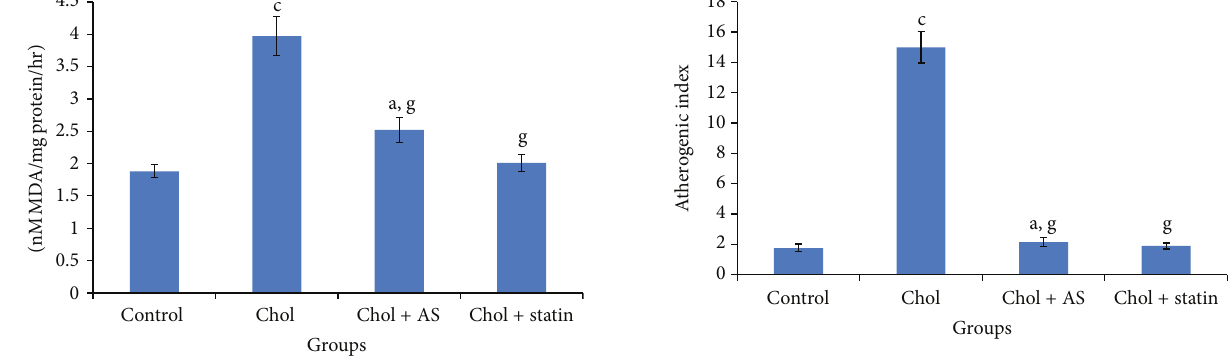
Figure 1: Effects of Acacia senegal seed extract (AS, 500 mg/kg/day, p.o.) or statin (0.25 mg/kg/day, p.o.) treatment for 45 days on the alteration in cardiac lipid peroxidation (nMMDA/mg protein/h) in hypercholesterolemic (Chol) diet fed atherosclerotic male rabbits. Data are means ± S.E.M. ( 𝑛 = 8 ); a, 𝑃 ≤ 0.05 and c, 𝑃 ≤ 0.001 as compared to the respective control values and g, 𝑃 ≤ 0.001 as compared to the respective values of the Chol diet fed group.